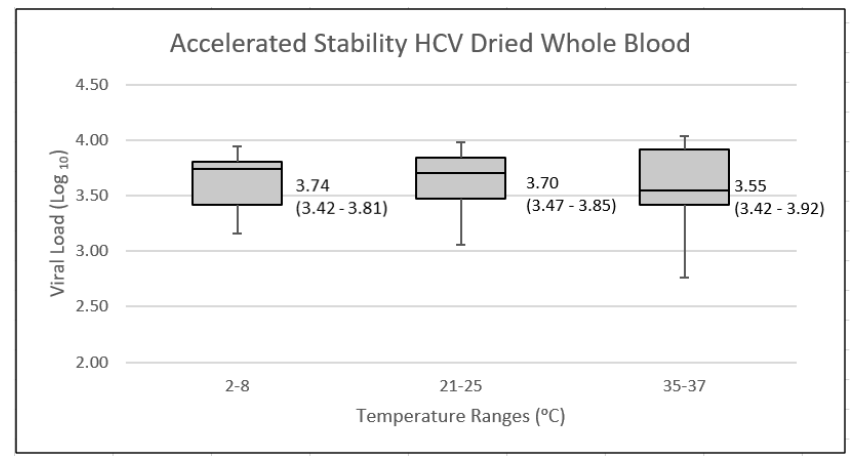
Figure 2. Box and whisker graph of HCV viral load results of dried tube samples store at various temperatures over a six-to-nine-month period. Media (quartile 1 and quartile 3) results, expressed in log 10 IU/mL are presented.